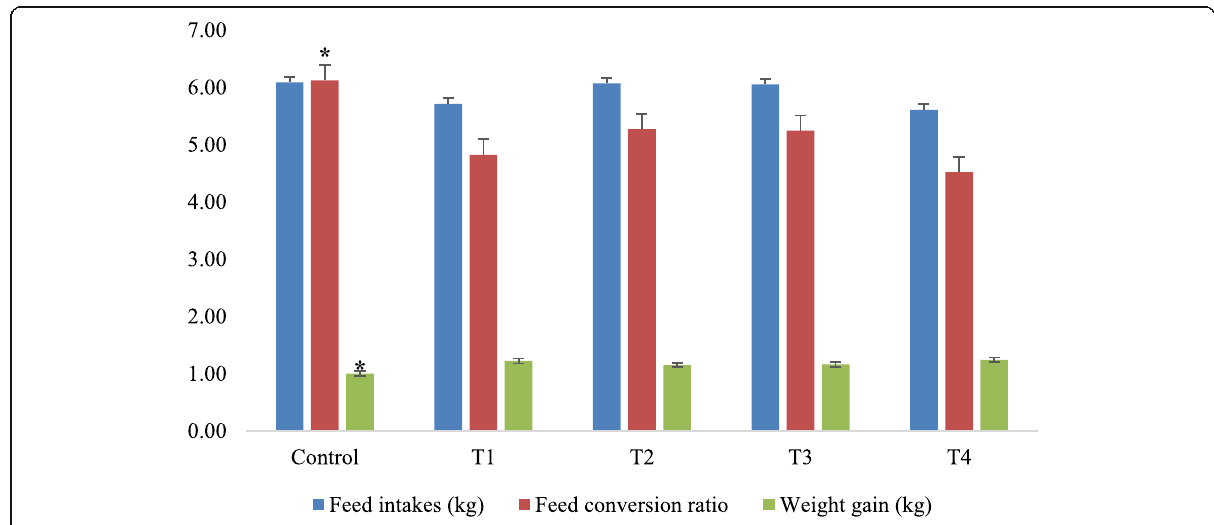
Fig. 1 Comparative effect of Chlorella vulgaris on feed use efficiency of the rabbits (* p < 0.05). Control — no supplementation, T1 — group supplemented with 200 mg Chlorella vulgaris biomass, T2 — group supplemented with 300 mg Chlorella vulgaris biomass, T3 — group supplemented with 400 mg Chlorella vulgaris biomass, and T4 — group supplemented with 500 mg Chlorella vulgaris